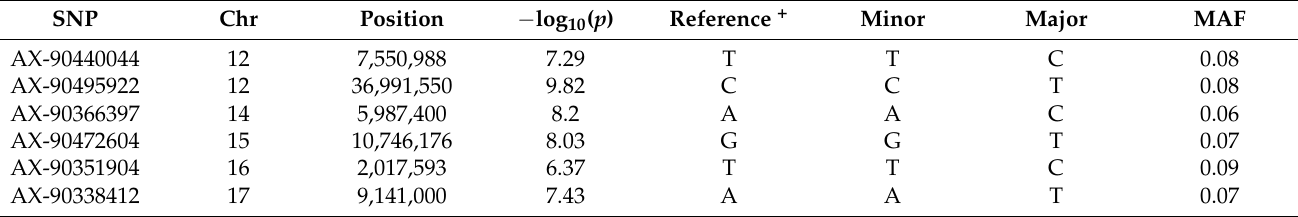
Table 3. Significant SNP markers related to DtM in the merged phenotype.